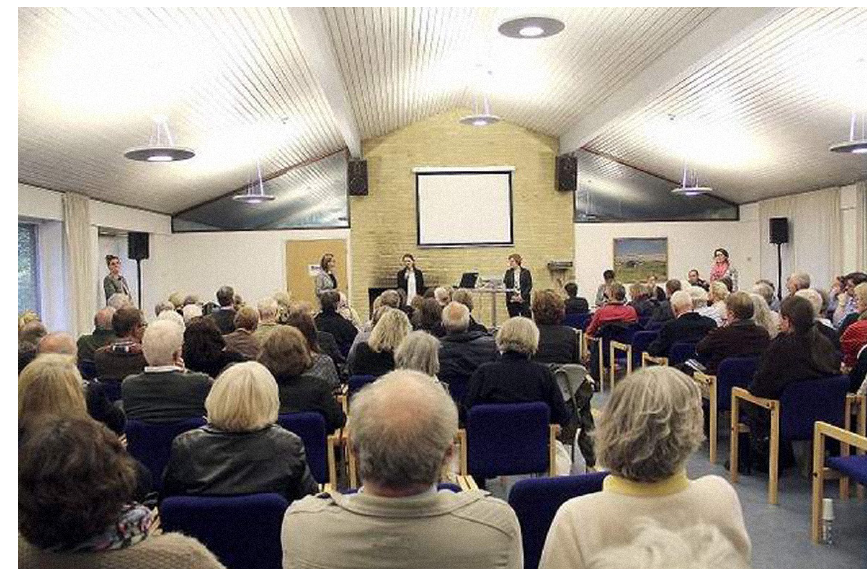
Figure 3. Public hearing at the former retirement home. May 2015, (Source: Hørsholm Lokalavis, 2015). gued is a part of the urban typography of private plots, is perceived as a product of persecution, fear and escape; a logic that captures the movement of the refugee in one dimension away from